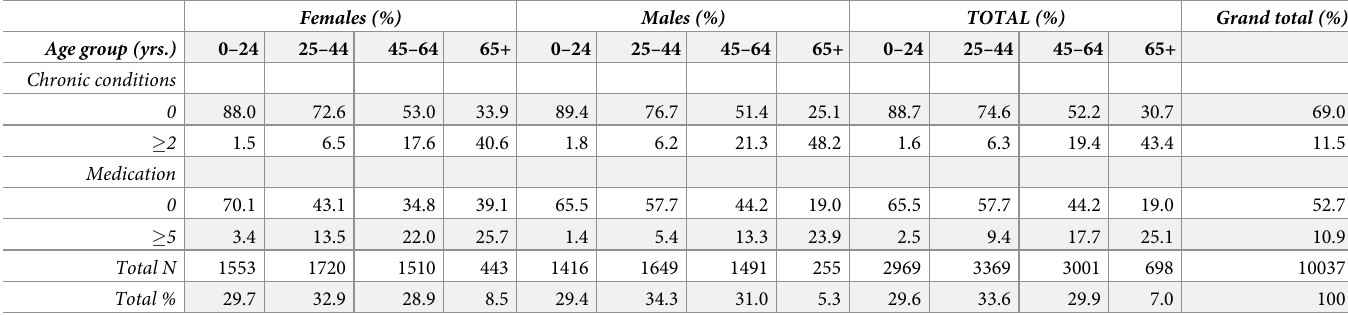
Table 2. Distribution of chronic health conditions and medications at baseline, stratified by age and sex (%). Females (%) Males (%) TOTAL (%) Grand total (%) Age group (yrs.)